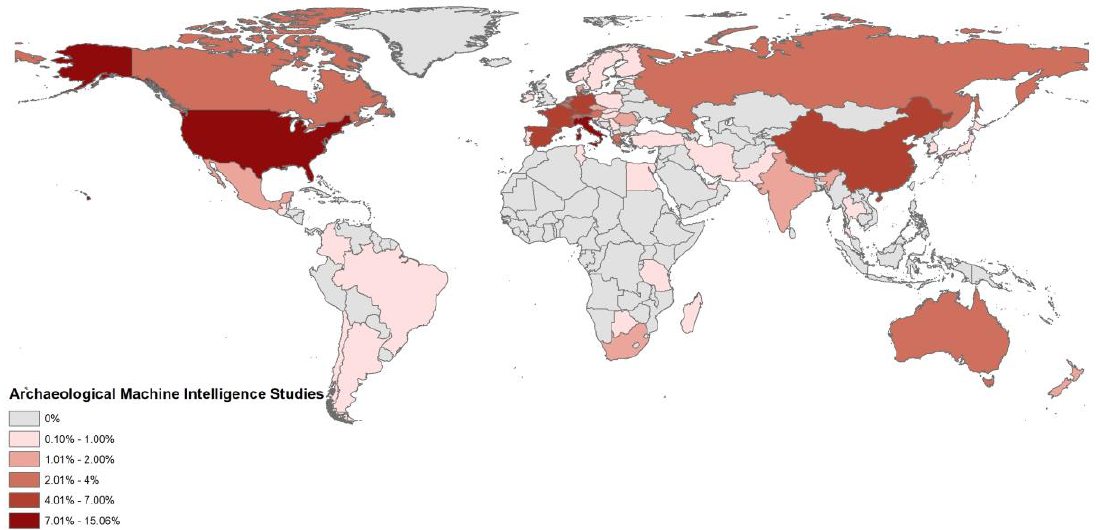
Figure 2. The percentage of papers (n = 148) published on machine intelligence for archaeological research (as of December 2019). This includes automated and semi-automated algorithms, AI, etc. developed for archaeology. Data collected from Web of Science.